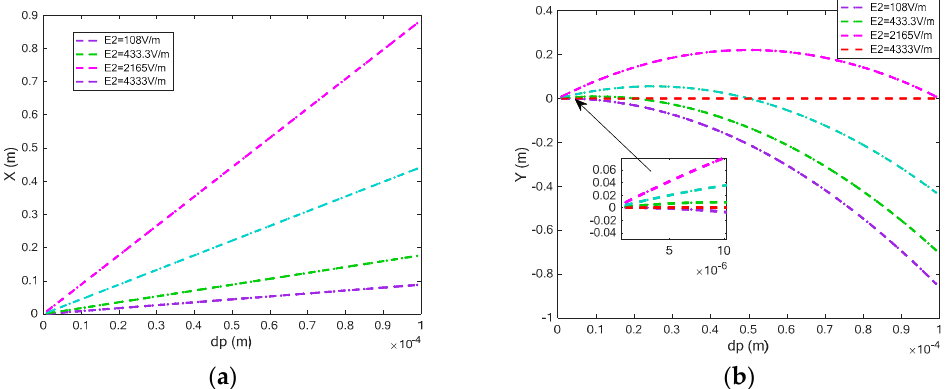
Figure 7. Particle diameter and displacement response: ( a ) X -axis displacement response; ( b ) Y -axis displacement response.